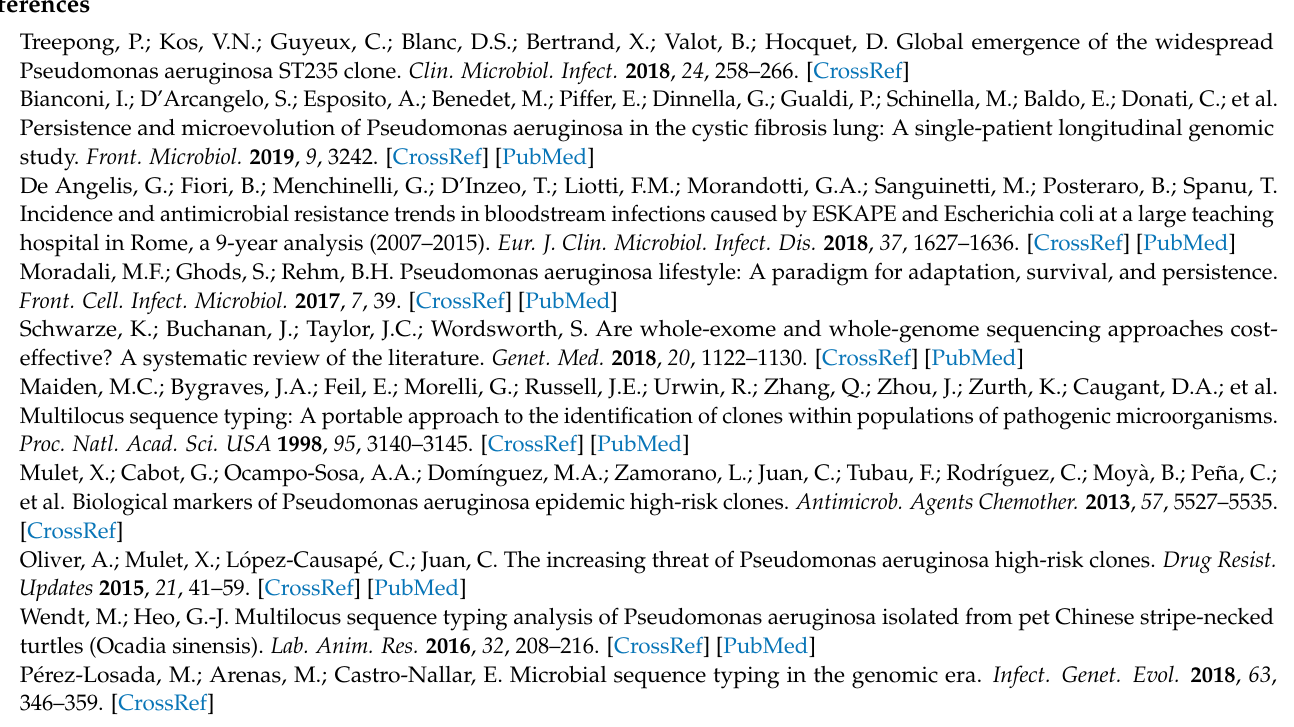
Table S3: List of phages identified in P. aeruginosa New sequence types genomes. Table S4: Core, Accessory and unique genes characteristics of the new sequence type isolates compared to the P. Pseudomonas species following CLSI guidelines. Table S6: List of virulence genes of reference strain PAO1 used in the study. Table S7: List of all reference strains used in the study along with their geographic region of